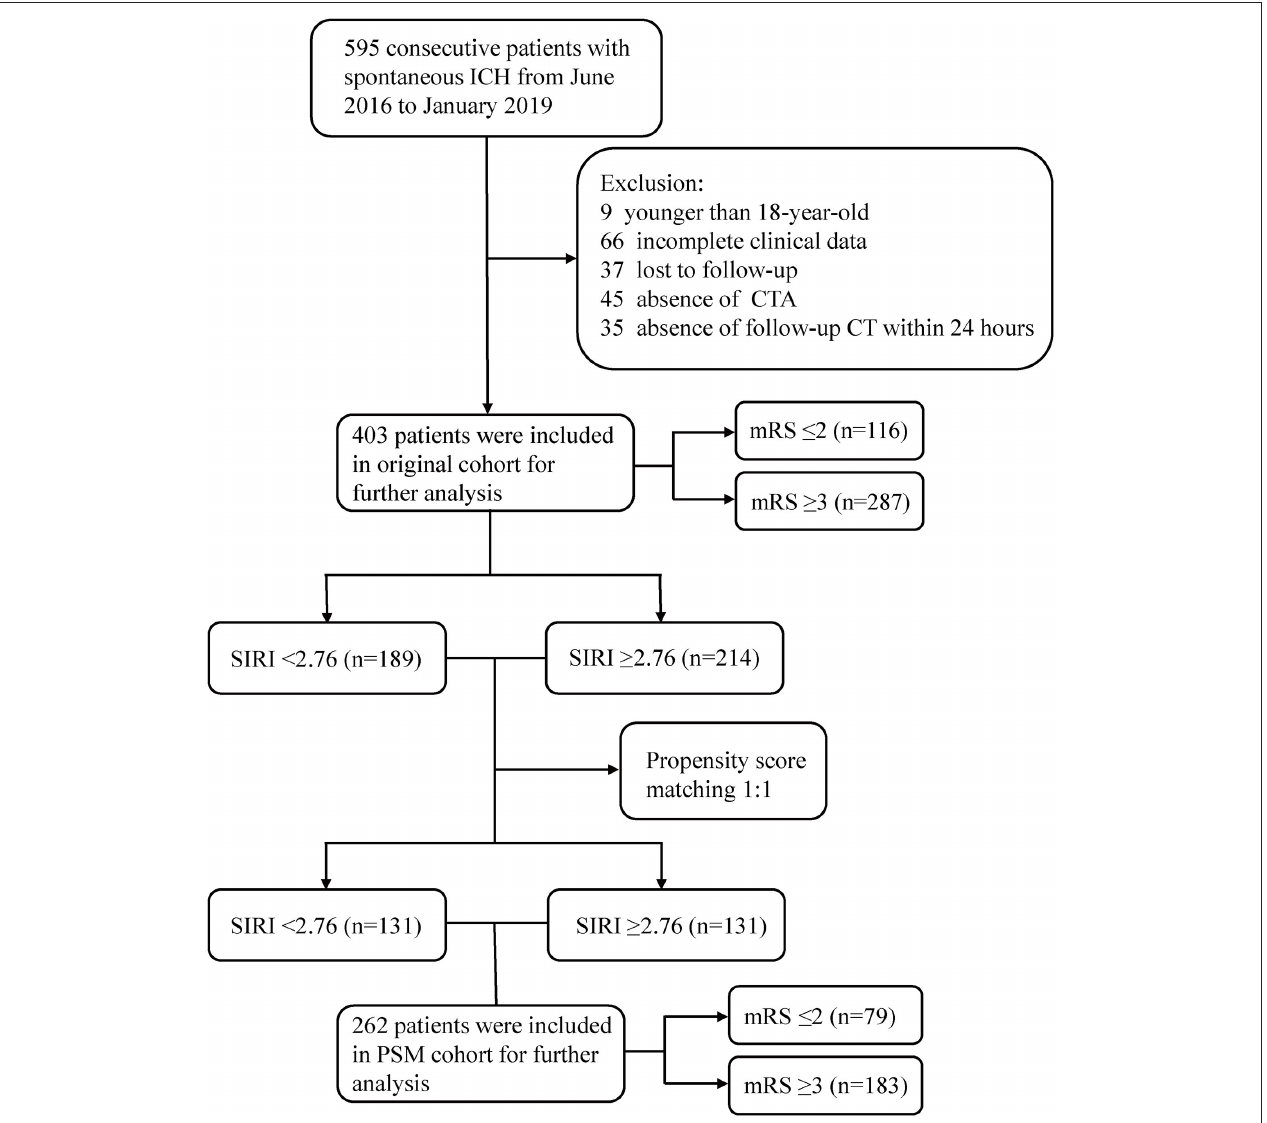
FIGURE 1 | Flow chart of the current study. ICH, intracerebral hemorrhage; CTA, computed tomography angiography; mRS, modified Rankin Scale; SIRI, systemic inflammation response index; PSM, propensity score matching.